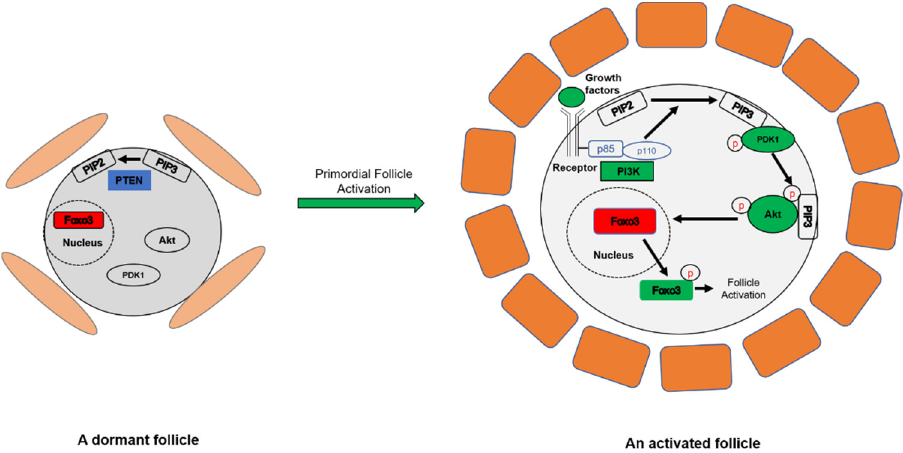
Figure 1. PI3K/PTEN signaling controls the activation of primordial follicles in the ovary. In dormant oocytes (left), PTEN reverts PIP2 back to PIP3 and prevents follicular activation. The downstream transcription factor Foxo3 is expressed in the nucleus. In growing oocytes (right), the PI3K–Akt signaling pathway is activated by converting PIP2 to PIP3. PIP3 then recruits both PDK1 and Akt to the cell membrane where PDK1 phosphorylates and activates Akt, resulting in Foxo3 hyperphosphorylation and nuclear export, which triggers the activation of the primordial follicle.